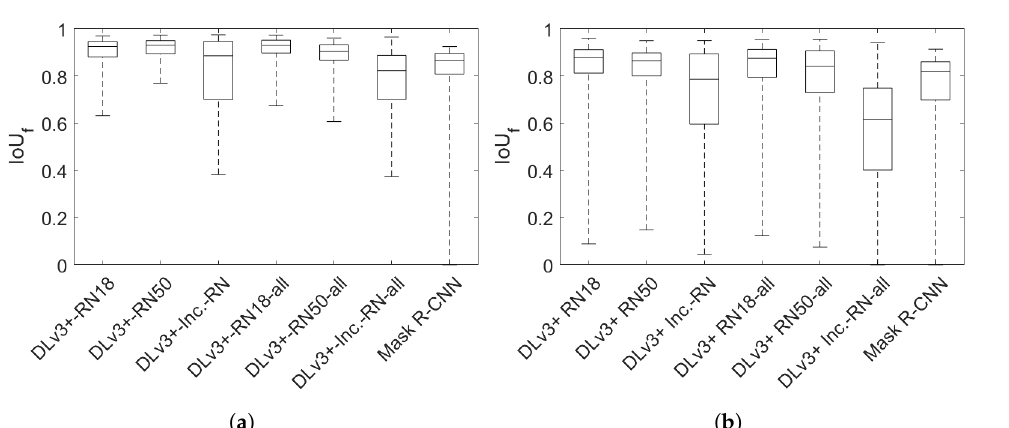
Figure 4. IoU f on test set for instance segmentation. Each box shows the IoU f of the segmentations obtained with different convolutional neural networks (CNNs). The boxed line represents the median, whereas the boxes itself include the 25 to 75 percentiles. The whiskers indicate the most extreme values. ( a ) Evaluation of flame 1. ( b ) Evaluation of flame